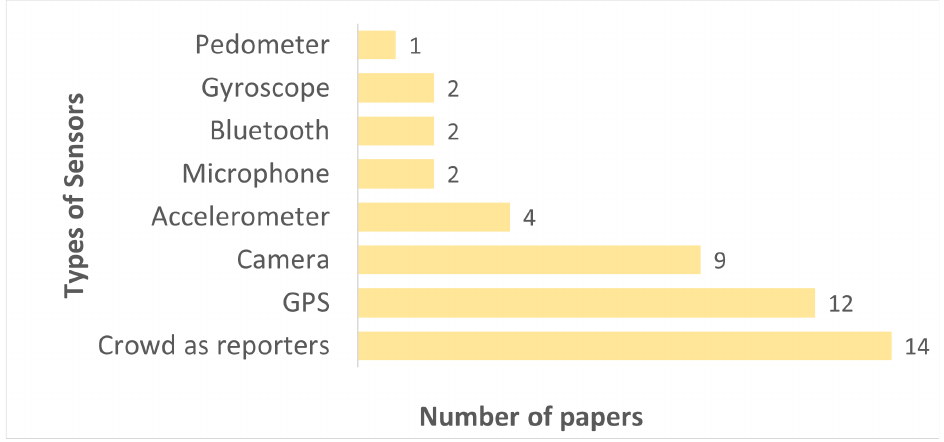
Figure 7. Types of Sensors Used in the Reviewed